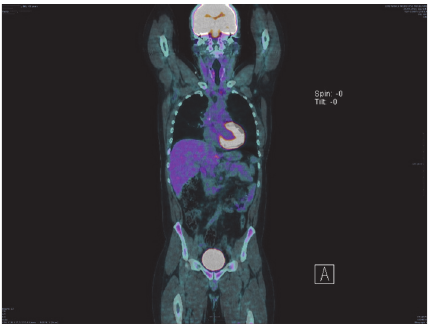
Figure 7: PET CT after